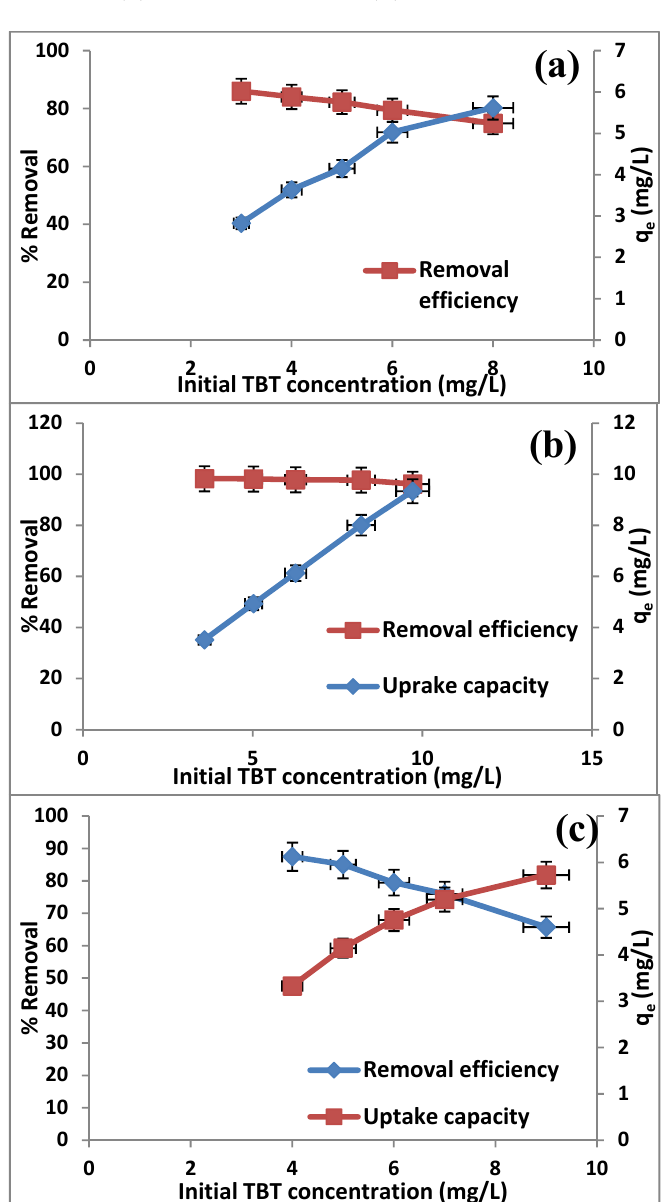
Figure 6. Effect of initial TBT concentration on the TBT removal efficiency and uptake capacity by MCM-TDI-C4 ( a ), MCM-TDI-PC4 ( b ) and MCM-TDI-C4S ( c